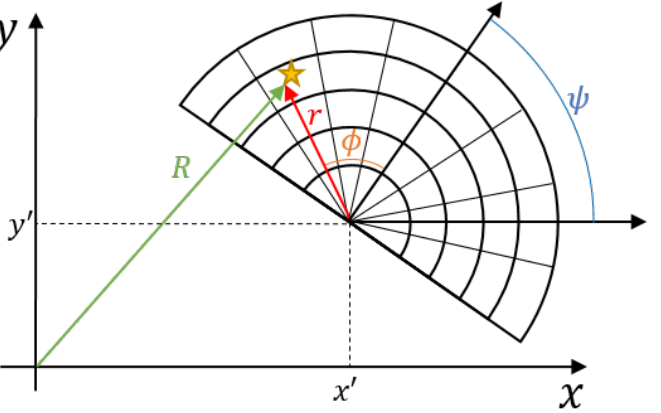
Figure 4. Roto-translated back-projection polar grid. The grid is centered in coordinates x (cid:48) and y (cid:48) , and it is rotated with an angle ψ with respect to the Cartesian reference. The TX/RX antenna is located in the origin of the Cartesian reference. The target is represented by the yellow